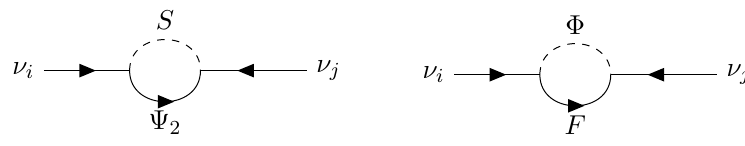
Figure 1 . Feynman diagrams associated to the generation of neutrino masses at the one-loop level in the model T1-2A in the interaction